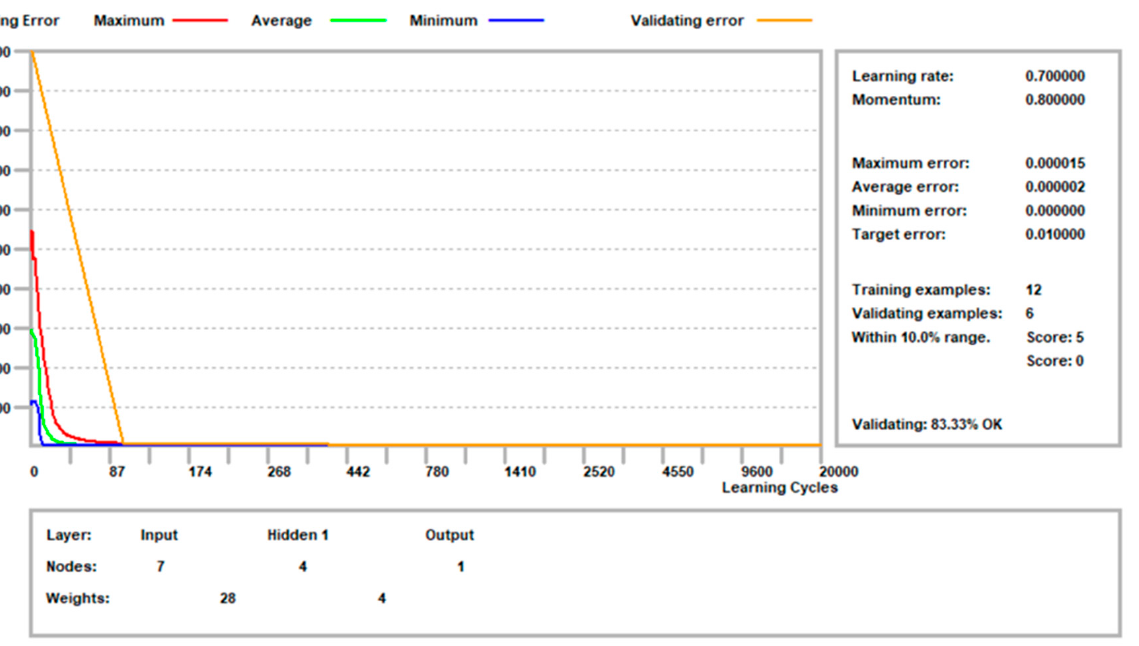
Figure 6 is a graphic visualization of the neural network in justNN.